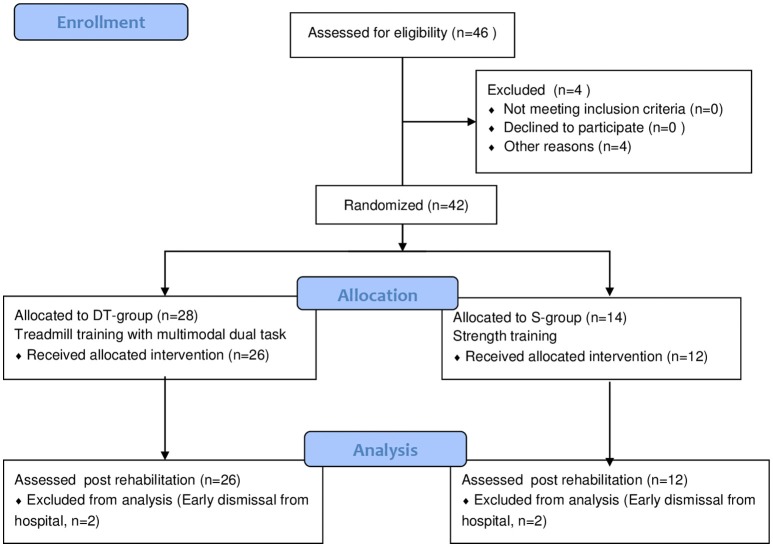
Flow chart of the study.